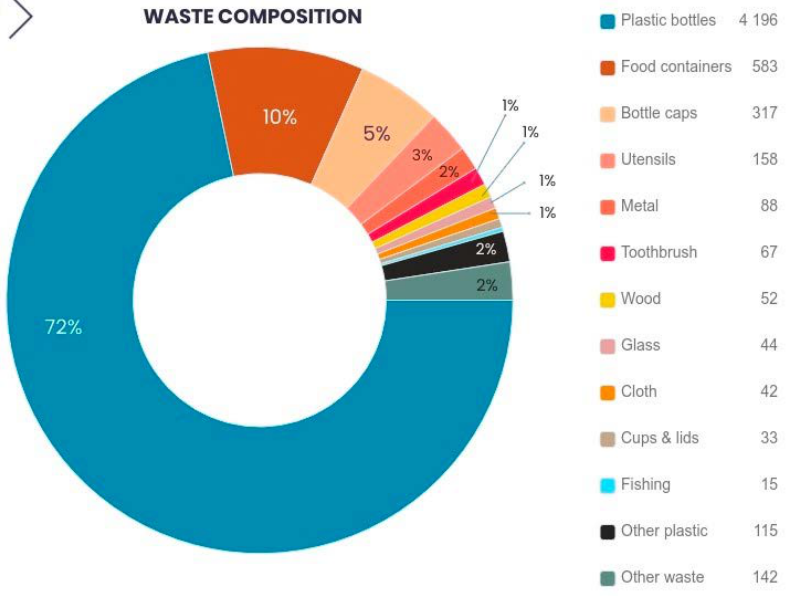
Figure 1. Waste composition from Port Maria beach clean-up activity in units (June 2021).